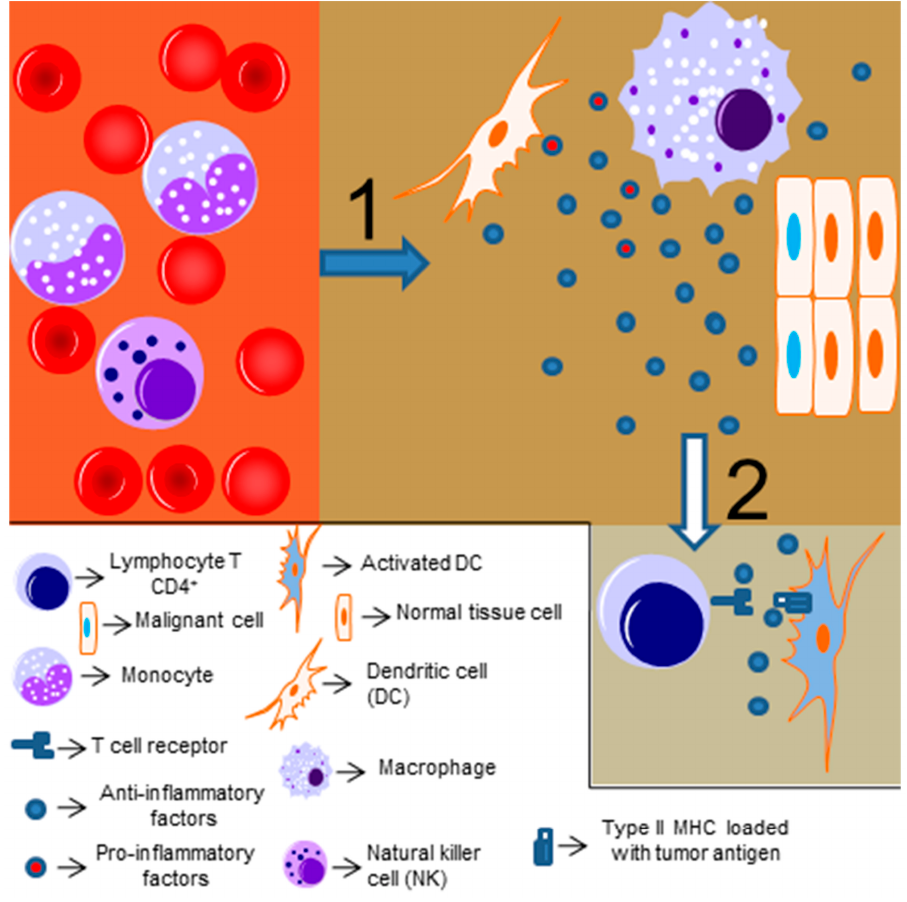
Figure 2. Immune response to tumors: ( 1 ) The loss of homeostasis driven by transformed cells will usually lead to tissue macrophage activation and an initial inflammatory response that will recruit other innate immune cells from nearby capillaries, like monocytes and Natural killer (NK) cells. After this initial phase, if the malignant cells are not cleared out, anti-inflammatory and regulatory factors, like IL-10 and TGF- β , can be secreted in order to restrain inflammation. Tumor cells can also secrete anti-inflammatory factors, rendering macrophages a tumor supportive phenotype, known as tumor associated macrophages (TAMs). ( 2 ) These anti-inflammatory factors will drive antigen presenting cells to promote a regulatory phenotype on naive T CD4+ lymphocytes (present in lymph nodes), which will restrain adaptive immunity to tumor antigens. The aim of immunotherapies nowadays is to revert this tumor permissive cycle, mainly through inhibition of receptors expressed by T cells that act as antitumor immunity silencers. In vitro co-cultures of macrophages and tumor cells not always support the role of tumor cells promoting an anti-inflammatory phenotype of macrophages. It seems that different tumors can induce different phenotypes on macrophages, even promoting its antitumor activity, through NF- κ B. How these tumors escape from immune response is not well understood, but different approaches to unleash the tumor immunity are needed in this case, and also when there is no immune cell infiltration on the affected tissue.